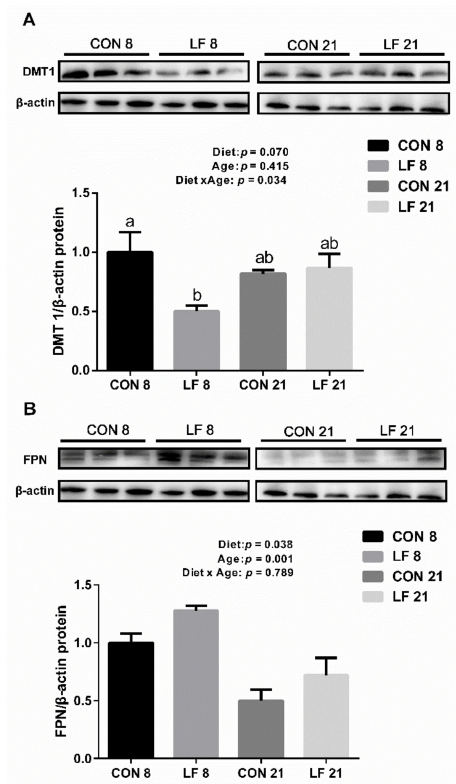
Figure 2. E ff ects of lactoferrin on protein expressions related to iron metabolism in the duodenum of suckling piglets. ( A ) divalent metal transporter 1 (DMT 1) ( B ) ferroportin (FPN). Values are means, standard errors represented by vertical bars, n = 6 per treatment. a-b Di ff erent letters mean significantly di ff erent for di ff erent groups at p < 0.05. Control group on day 8 (CON 8); Lactoferrin group on day 8 (LF 8); Control group on day 21 (CON 21); Lactoferrin group on day 21 (LF 21).